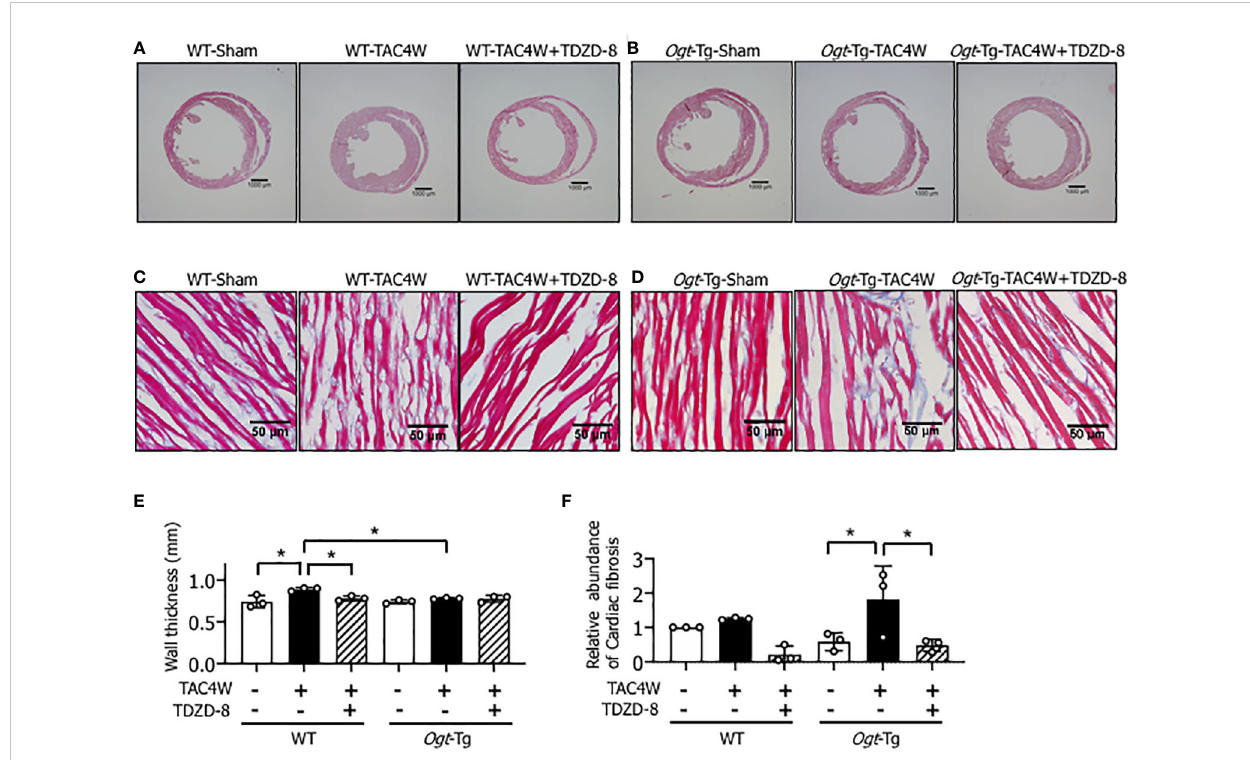
FIGURE 4 Restoration of compensatory cardiac hypertrophy and fi brosis by the treatment of TDZD-8 in Ogt-Tg mice after TAC4W. (A – F) Masson's trichrome staining in heart tissues from TAC4W-treated WT and Ogt-Tg mice with or without TDZD-8 (10 mg/kg/day, 3 weeks, IP). Scale bar: (A, B) = 1000 m m, (C, D) = 50 m m. (E) Quantitative analysis of interventricular wall thickness evaluated by Masson's trichrome staining presented in (A – D) . The data were evaluated by two-way analysis of variance (ANOVA) followed by Tukey ’ s test. Values are shown as mean±SD (n=3). *P<0.05. (F) Quantitative analysis of cardiac fi brosis evaluated by Masson's trichrome staining presented in (A – D) . The data were evaluated by two-way analysis of variance (ANOVA) followed by Tukey ’ s test. Values are shown as mean±SD (n=3). *P<0.05. TAC, transverse aortic